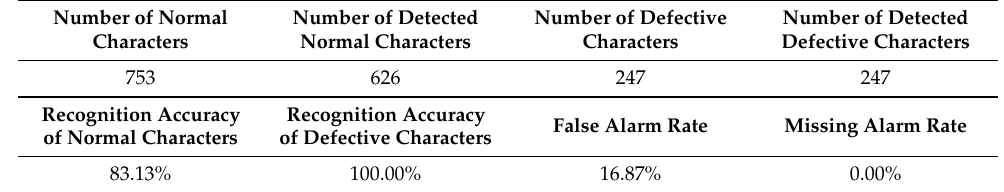
Table 6. Spatial Pyramid Character Proportion Matching (SPCPM) results of character recognition.